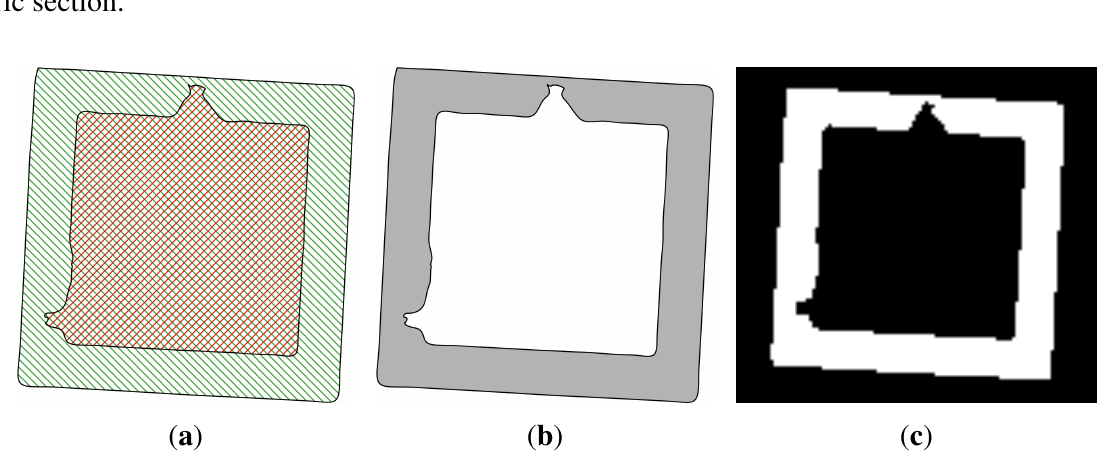
Figure 9. Second part of the slicing workflow (2D data). ( a ) Internal (red), external (green); ( b ) filled slice; ( c ) bitmap: 116 107 ×